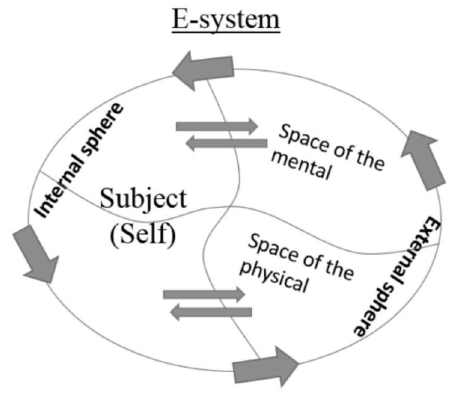
Figure 2. E-model of